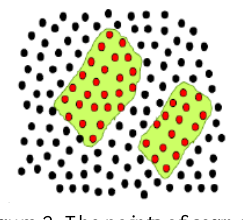
Figure 2. The points of segment